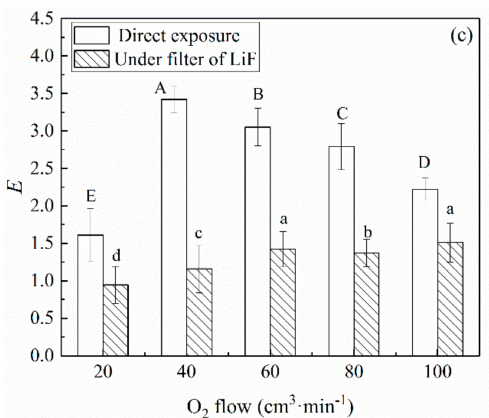
Figure 2. Comparison of the decontamination e ff ect between oxygen plasma total and UV radiation individual under di ff erent treatment conditions ( a ) Time 60 s, O 2 flow 40 cm 3 · min − 1 , Pressure 45 Pa; ( b ) Power 100 W, O 2 flow 40 cm 3 · min − 1 , Pressure 45 Pa; ( c ) Power 100 W, Time 60 s, Pressure 45 Pa. Capital letters A–E are distinguished from a–d to represent statistical significance in direct